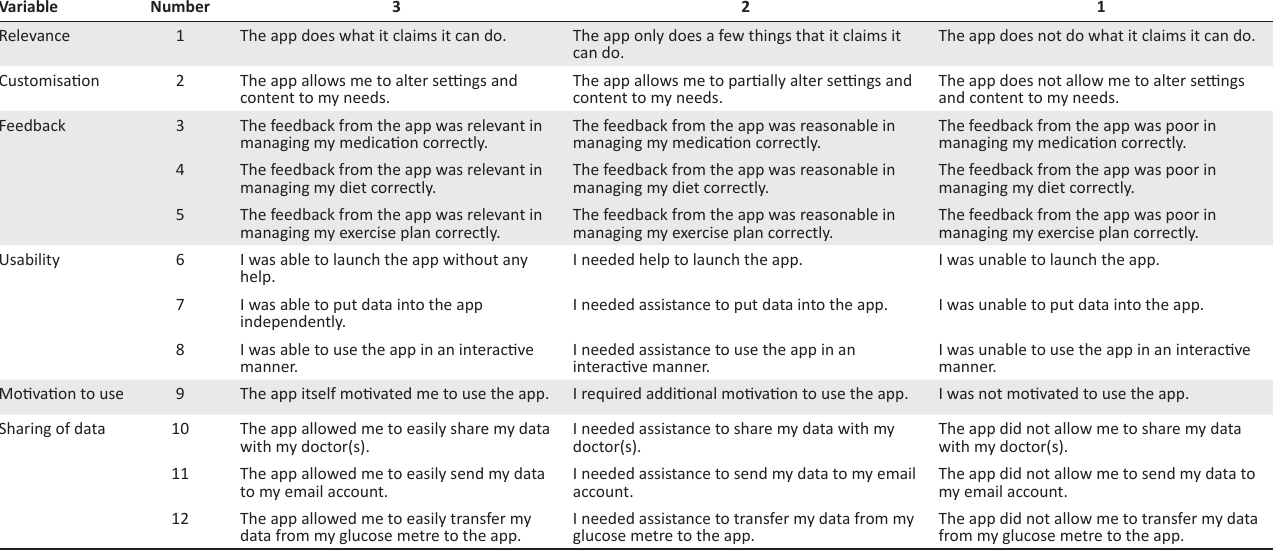
TABLE 1: mHealth app evaluation criteria